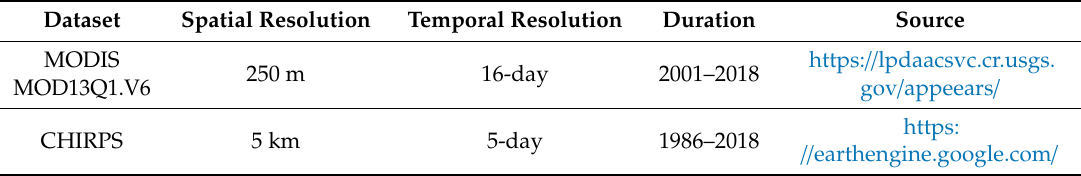
Table 1. Description of original datasets used in the